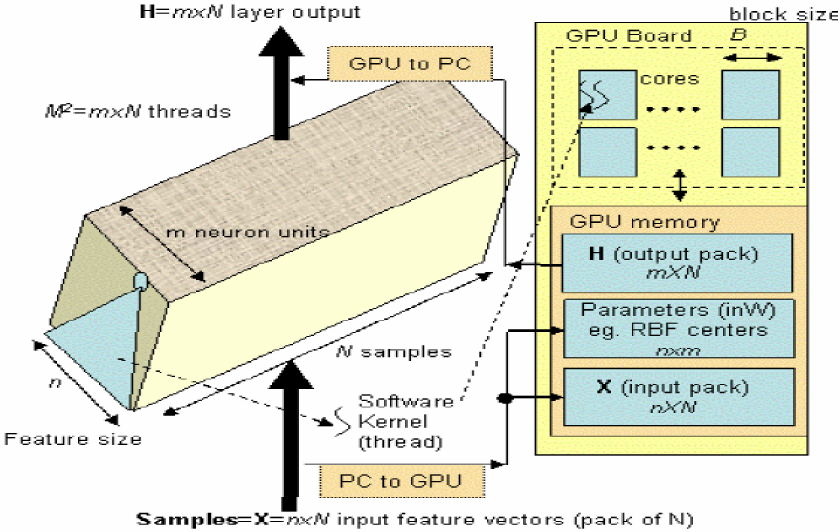
Figure 10. BNL neural model and mapping to GPU [64]. (Reprinted with permission from ref. [64]. Copyright 2021